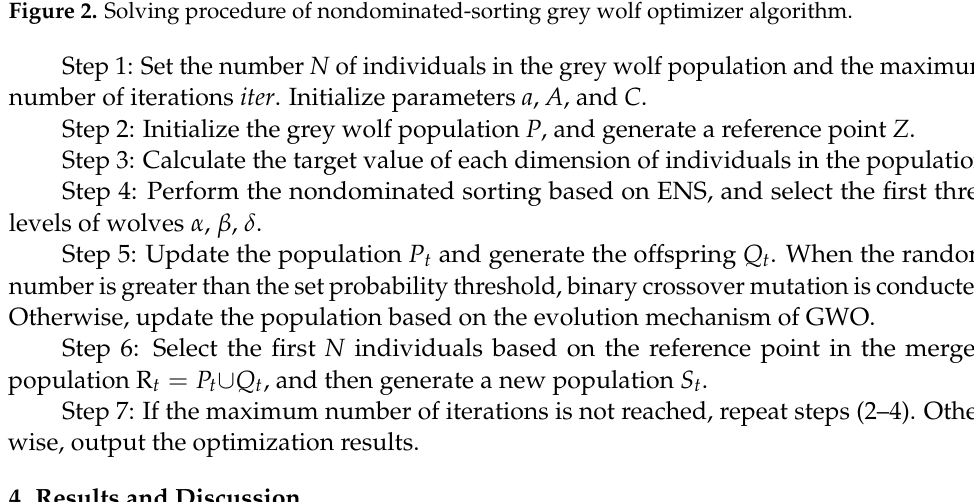
Figure 2. Solving procedure of nondominated-sorting grey wolf optimizer algorithm.